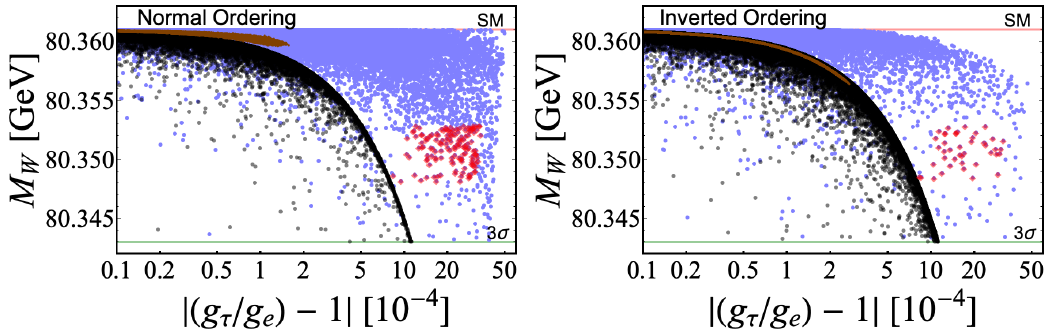
Figure 3 . Correlations among M W and deviations of g τ /g e from universality. The colours are the same as in figure 2.